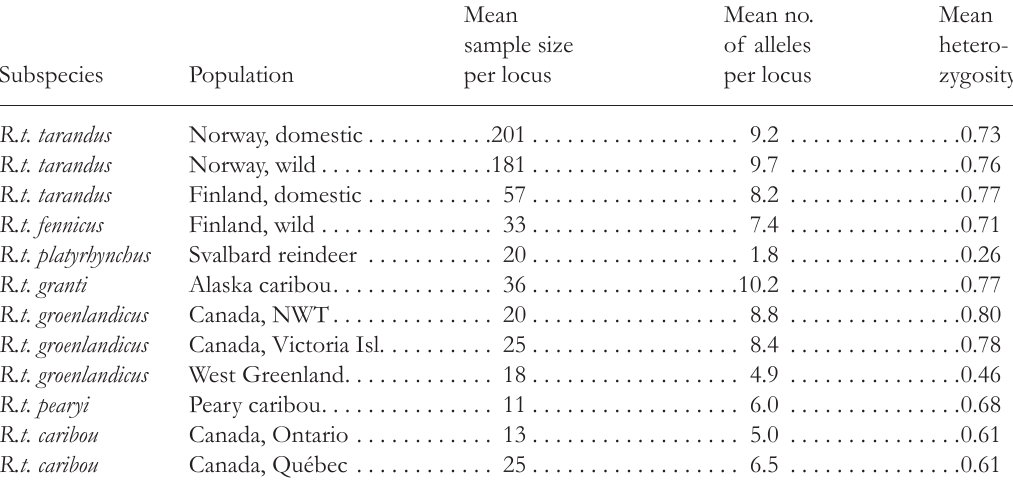
Table 2. Genetic variability in 13 microsatellite loci in subspecies of reindeer and